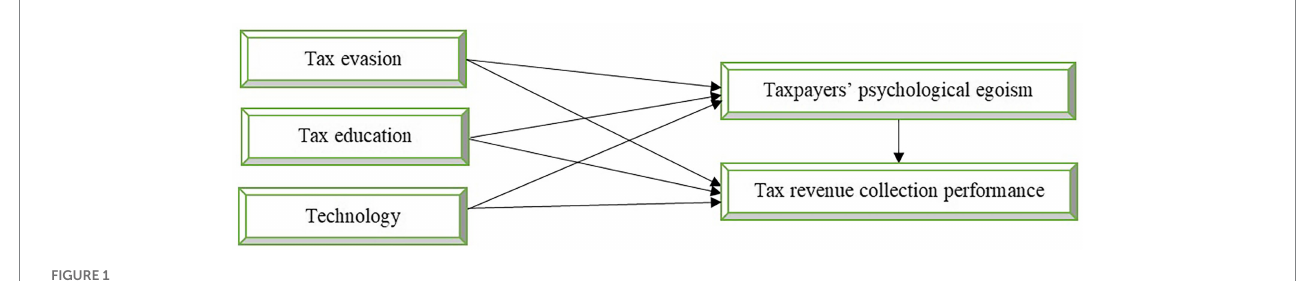
FIGURE 1 Conceptual